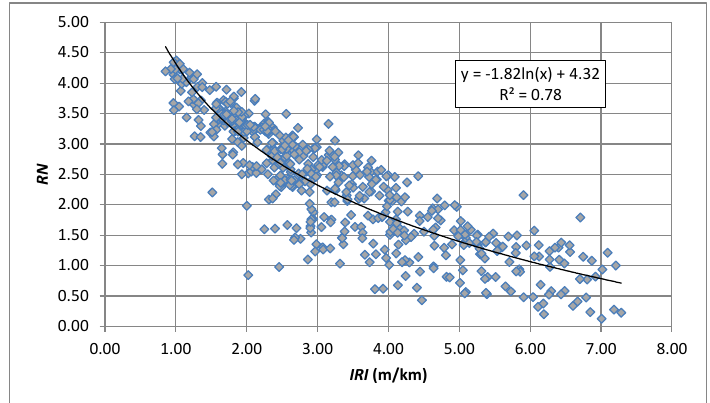
Figure 12. Correlation between RN and IRI .